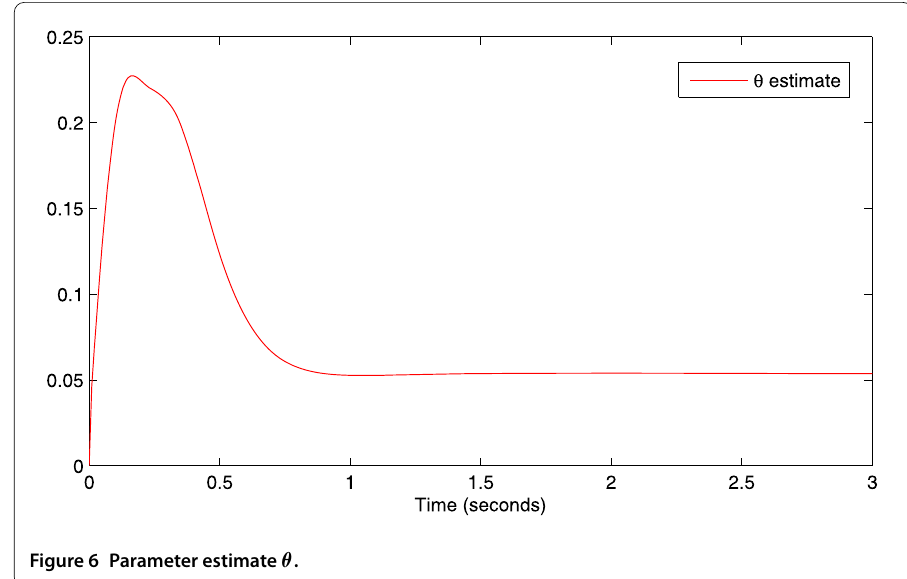
Figure 6 Parameter estimate θ